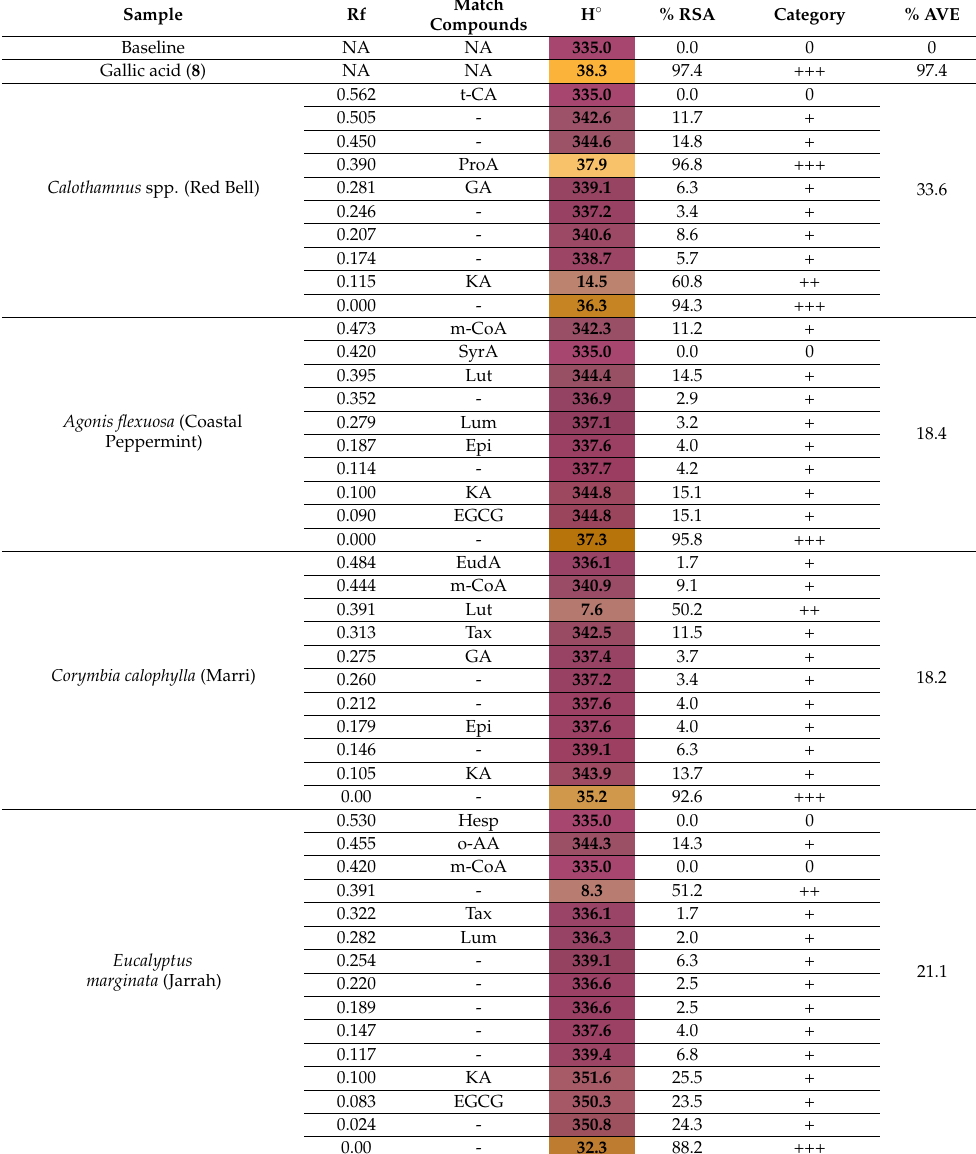
Table 8. Percentage DPPH RSA antioxidant activity of individual bands in Calothamnus spp. (Red Bell), Agonis flexuosa (Coastal Peppermint), Corymbia calophylla (Marri) and Eucalyptus marginata (Jarrah) honey along with their corresponding matched